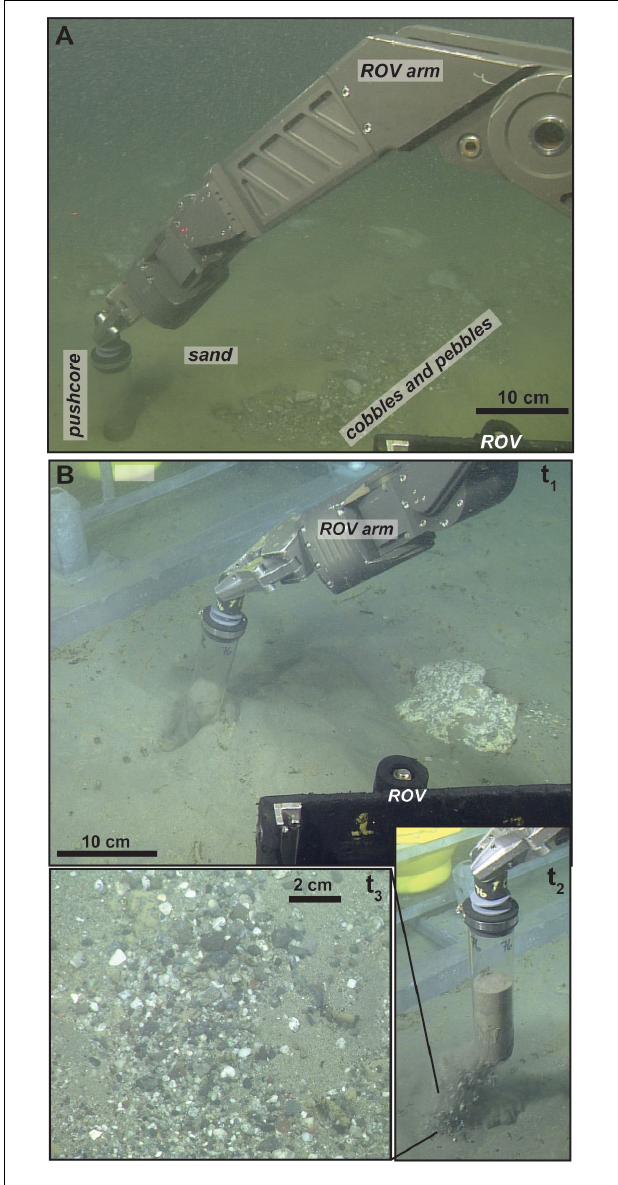
FIGURE 9 | Remotely operated vehicle (ROV) photographs of seafloor heterogeneity observed during pushcore sampling. (A) Photograph of pushcore DR835 PsC-69 from an area of sand adjacent to exposed cobbles and pebbles. (B) Photographs of DR896 PsC-76 acquisition at times t 1 – t 3 . Large clasts are exposed adjacent to the pushcore (t 1 ), and buried pebbles fell out of the base of the pushcore (t 2 and t 3 ).